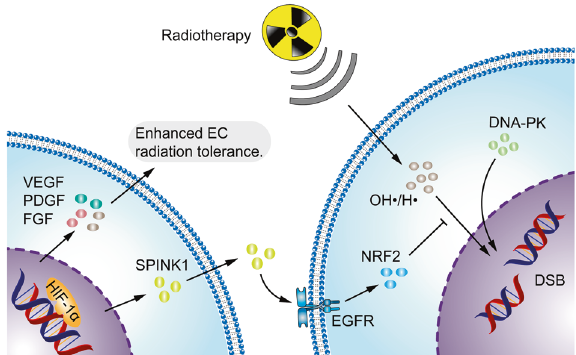
Fig. 8 Hypoxia enhances the ability of the tumor to resist radiotherapy. Radiotherapy induces cancer cell death by directly damaging DNA through the production of free radicals such as OH (cid:129) and H (cid:129) . SPINK1, secreted by hypoxic cancer cells, upregulates EGFR and NRF2 antioxidant response in adjacent cancer cells to reduce radiation-induced DNA damage, thereby inducing cancer radio- resistance. VEGF, FGF and PDGF secreted by hypoxic cancer cells enhanced the radiation resistance of ECs. HIF-1 α stimulates DNA-PK expression and repairs DNA DSB Fig. 7 Hypoxia enhances tumor chemotherapy resistance. IL-6